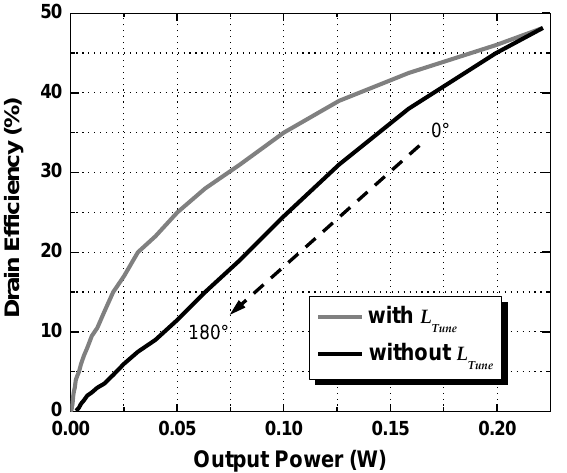
Figure 10. Simulated drain efficiency versus output power.